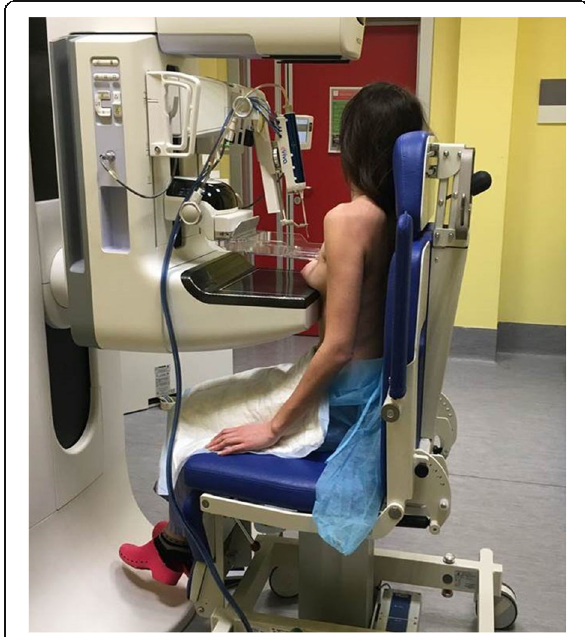
Fig. 3 Mammography-guided (stereotactic) vacuum-assisted biopsy. The patient is sitting on a dedicated chair. After local anaesthesia, the needle is guided to the lesion by the computer on the basis of specifically acquired mammographic